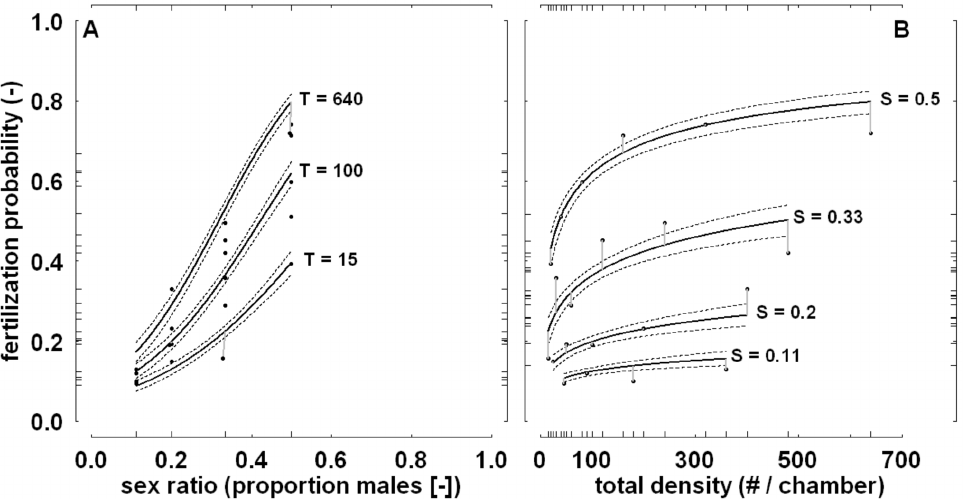
Figure 7. Fertilization probability in relation to sex ratio (panel A) and total density (panel B). Data concerns female Drosophila and is from the experiment presented in Wallace [3]. Presented are back-transformed values. Superimposed are the back-transformed fitted linear regression lines (continuous lines) and 95% confidence intervals (dotted lines) calculated at specific levels of total density ‘T’ or sex ratio ‘S’. Grey lines show residuals associated with the depicted regression lines (for representational purposes, corresponding observations have been slightly shifted horizontally in panel A). Long tick marks indicate treatment levels and response values. Note the log-scale of the x-axis in panel B.